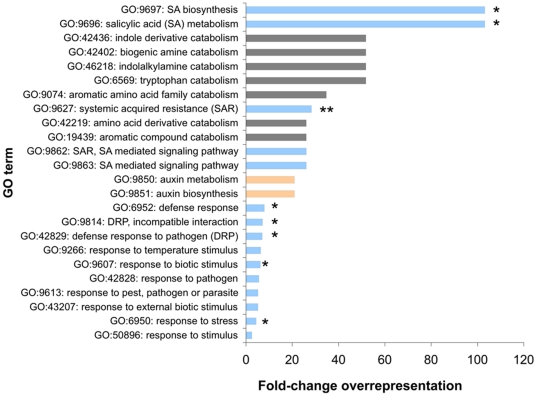
Biological function of NMD-regulated genes.Biological function gene ontology (GO) terms that are over-represented (p<0.05) amongst the 206 genes that are commonly up-regulated in NMD mutant plants. The horizontal bar indicates the proportion of the 206 NMD genes with the given GO term relative to the proportion of the genome with the same GO term. DRP is defence response to pathogen, SA is salicylic acid and SAR is systemic acquired resistance. GO terms relating to response to stimuli are coloured blue. GO terms relating to auxin metabolism are coloured peach. The remainder are all associated with amino acid catabolism. * p value≤0.01. ** p value≤0.001.